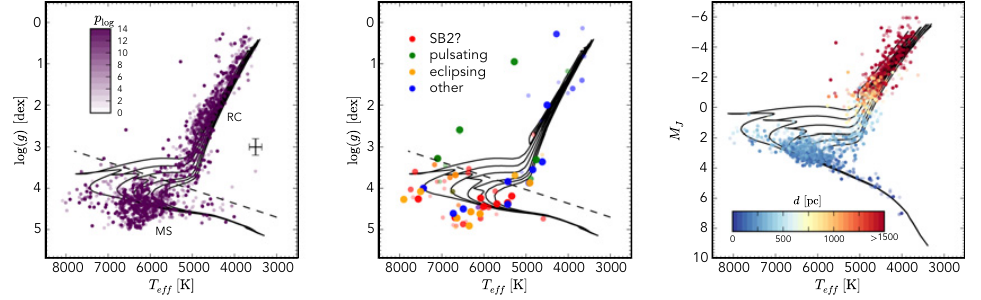
Figure 1. { T eff ,log( g ) } diagrams of the identified SB1 objects. See text for